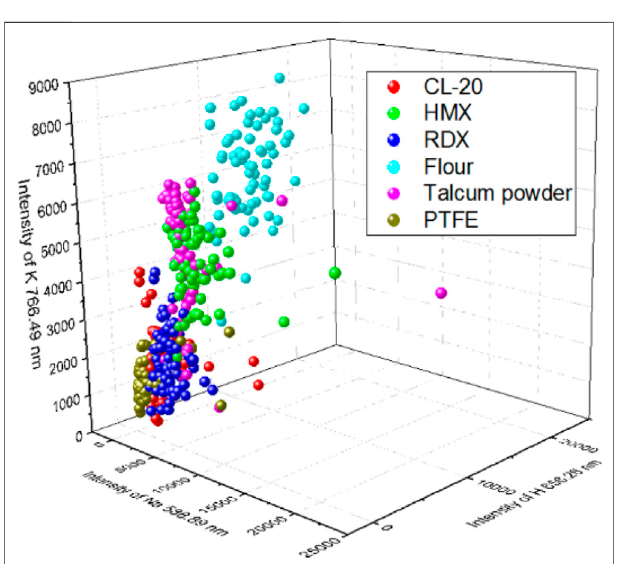
FIGURE 4 | 3D plot of the intensity of Na 588.89 nm, H 656.28 nm, and K 766.49 nm.